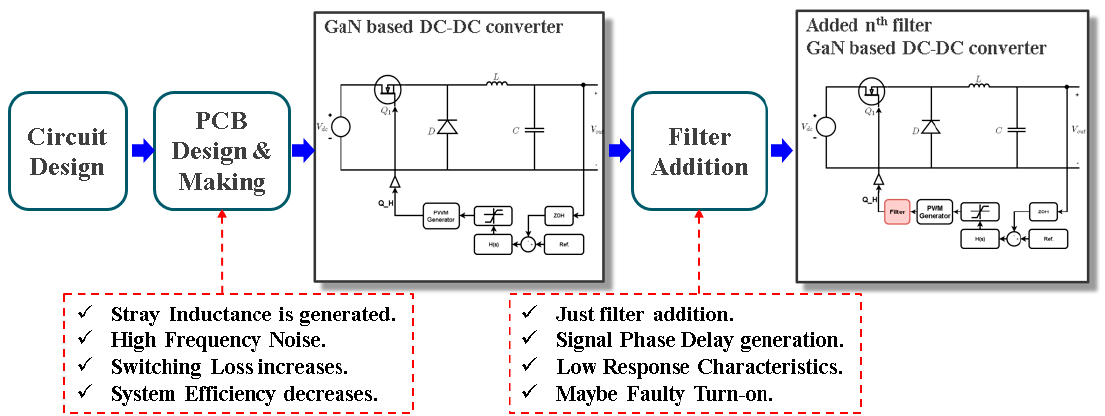
Figure 1. The traditional WBG device system design and compensation flow.